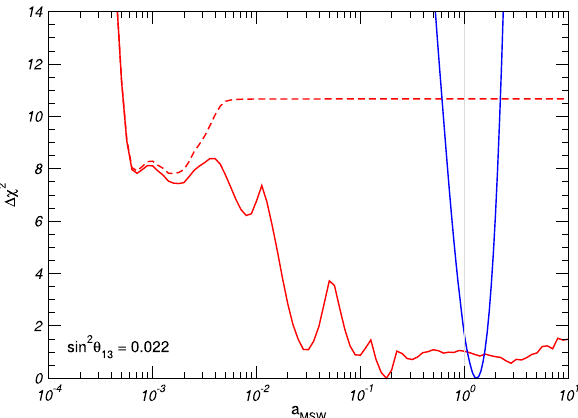
Fig. 9 Atmospheric ν μ + ¯ ν μ disappearance probability difference between the standard case and decoherence cases. Differences are shown for n = 0 (left) and n = 2 (right). Here, the x-axis is energy, and the y-axis is cosine of zenith angle which is related to the propagation